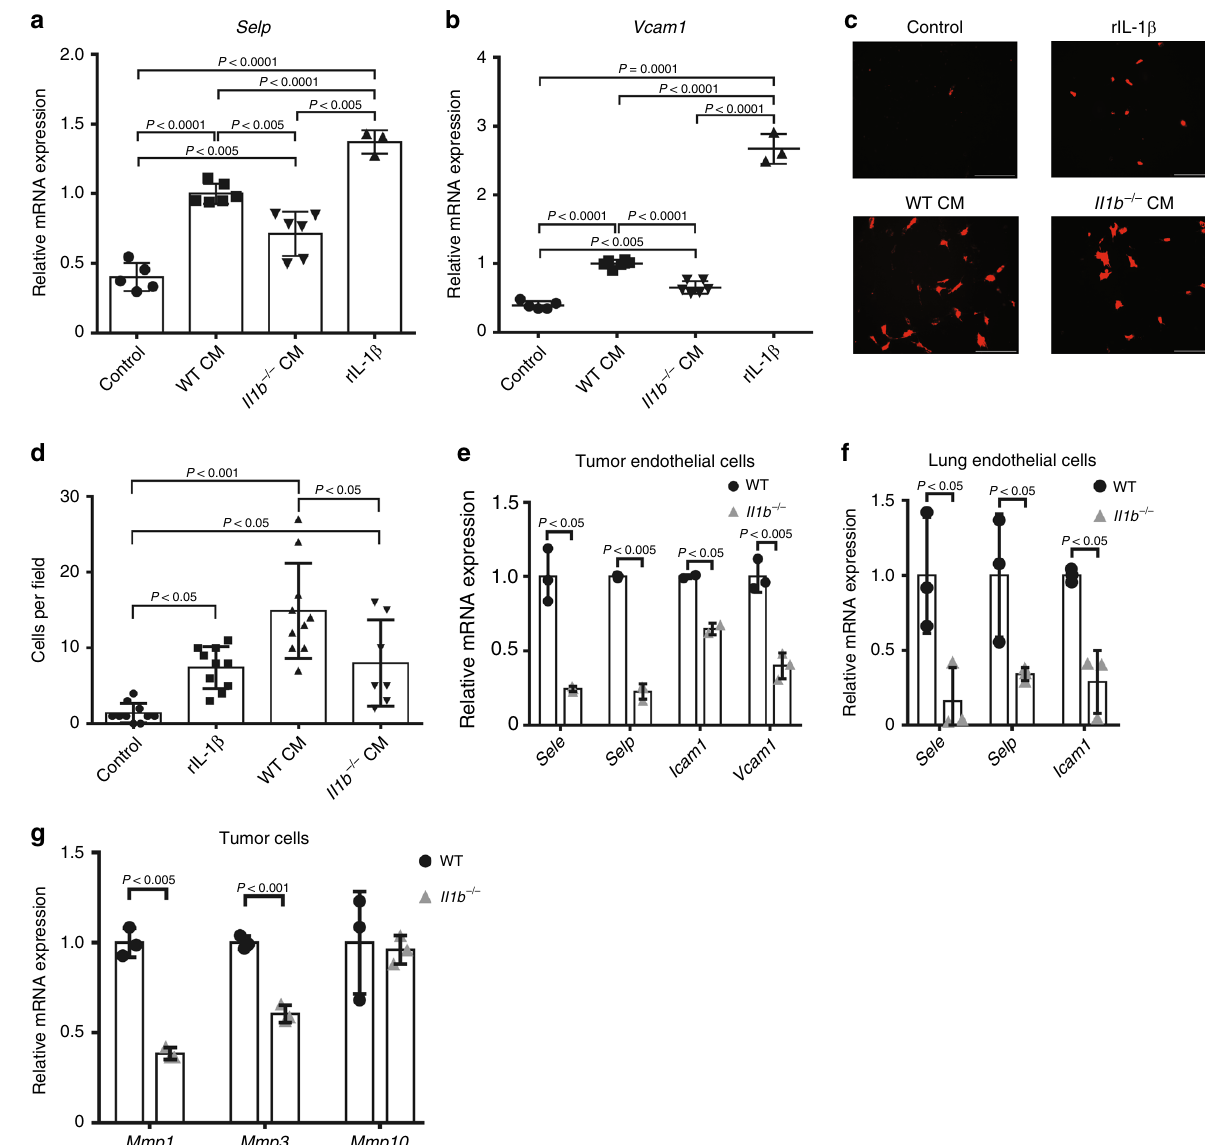
Fig. 6 CAF-derived IL-1 β upregulates expression of EC adhesion molecules and invasiveness markers. a , b C166 endothelial cells were incubated for 24 h in control medium, medium containing recombinant IL-1 β (5 ng/mL), conditioned medium of MSU-treated WT mammary fi broblasts (Balb/C), or conditioned medium of MSU-treated Il1b − / − fi broblasts. The expression of genes involved in tumour-cell intravasation/extravasation was analysed using qRT-PCR. Representative of three independent experiments. c , d Trans-endothelial migration of mCherry-labelled Met-1 cells supplemented with recombinant IL-1 β (5 ng/mL), conditioned medium of WT NMFs, conditioned medium of Il1b − / − NMFs, or control medium. c Representative images of trans-migrated Met1-mcherry cells. Scale bar, 100 μ m. d Quanti fi cation of migrating cells per fi eld of view. Representative of two independent